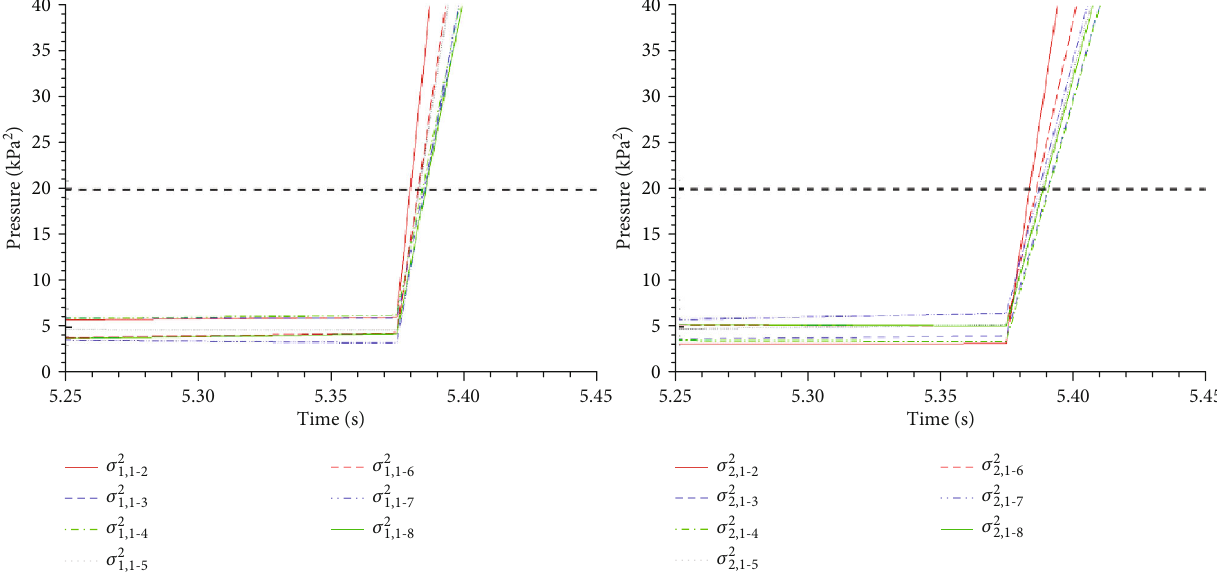
Figure 17: Results of the heterotopic variance analysis of the inlet static pressure during compressor instability.